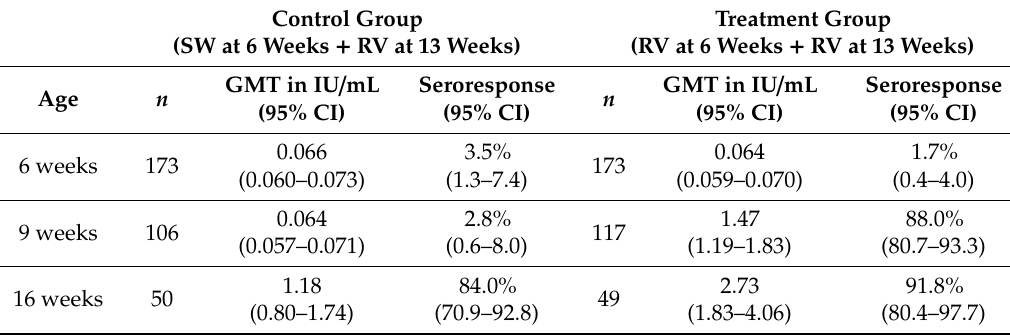
Table 2. Rabies virus neutralizing antibody titers (RVNA) in the treatment and control groups at 6, 9, and 16 weeks of age, showing geometric mean titers (GMT) and percentage seroresponding (RVNA titers ≥ 0.5 IU /